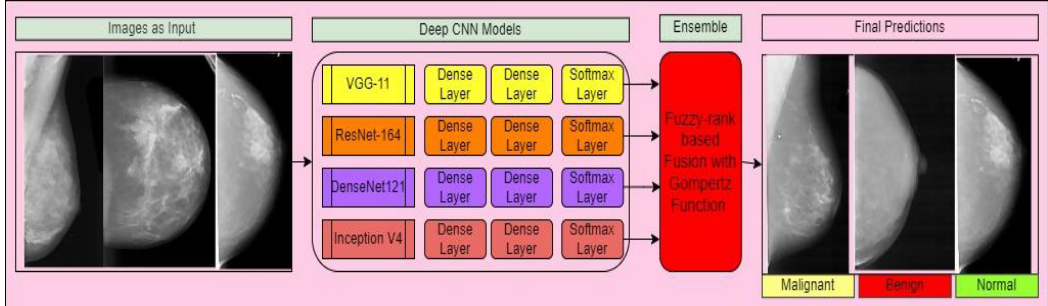
Diagnostics 2022 , 12 , x FOR PEER REVIEW Figure 6. Workflow of the proposed framework. Figure 6. Workflow of the proposed framework.